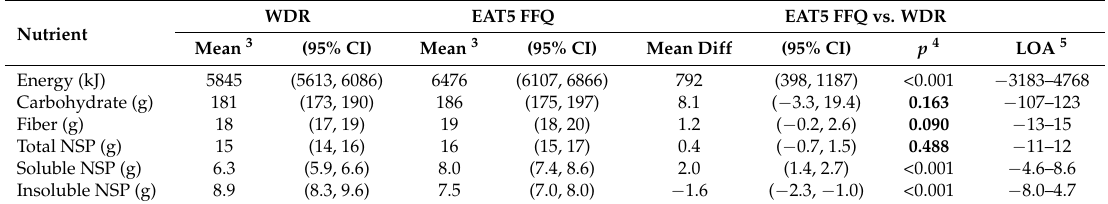
Table 1. Mean daily intake, mean difference, and limits of agreement for selected nutrients of relevance to the gut microbiota according to WDR and EAT5 FFQ in 5-year old children ( n = 100) 1,2 . Nutrient